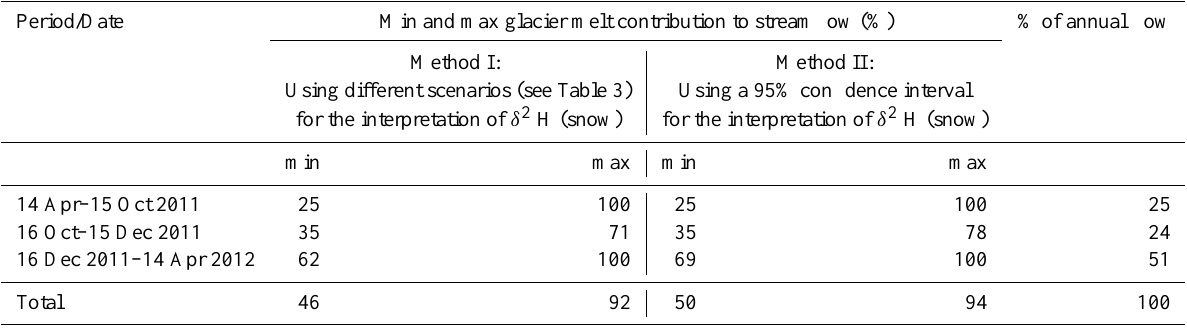
Table 4. Relative contribution of glacier melt to streamflow in three different periods and during one year. Minimum and maximum con- tributions were determined using different scenarios, each defining a different snow isotope composition (Method I). In Method II, a 95% confidence interval was used for determining the isotopic composition of snowmelt and glacier